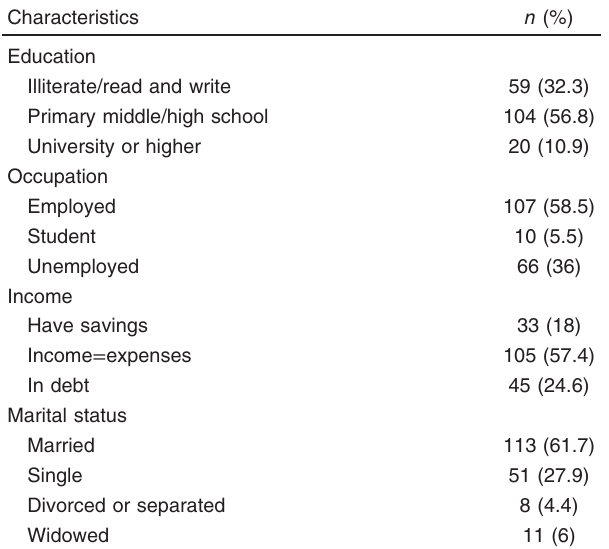
Table 2 Sociodemographic characteristics of studied patients (education, occupation, income, and marital status) ( N = 183) Characteristics